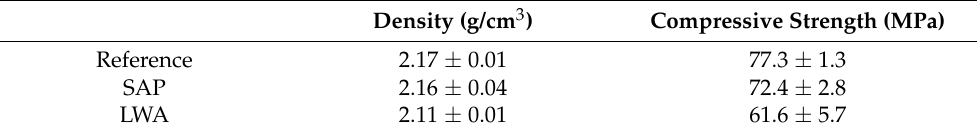
Table 2. Density (g/cm 3 ), flexural strength (MPa) and compressive strength (MPa) of mortar